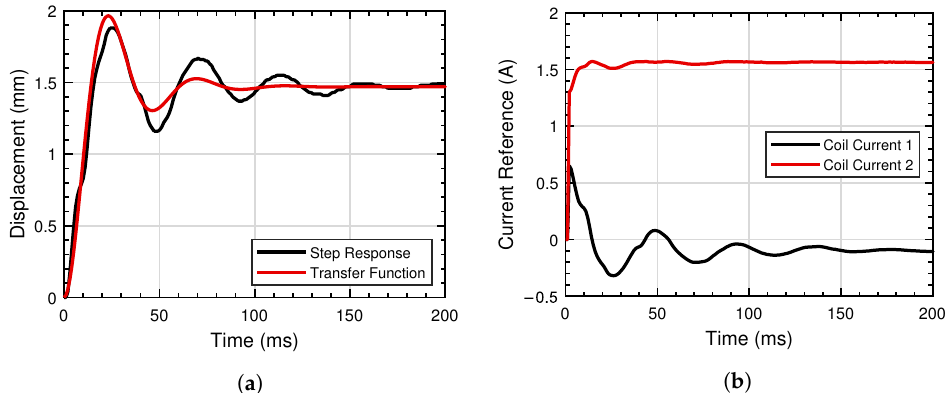
Figure 9. The open-loop step response from a one Newton step input compared against the transfer function used to model the control system ( a ) and the individual coil currents required to meet the 1N step, continuously changing based on the Hall feedback ( b ).